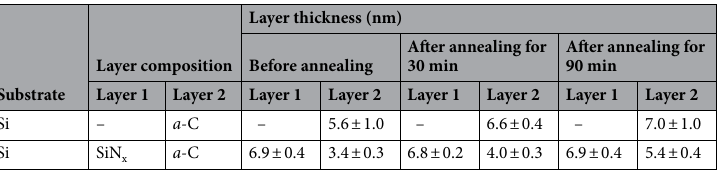
Table 1. Stack configurations and layer thickness estimated from EELS spectra acquired before and after RTA at 250 °C in Ar atmosphere for 30 and 90 min.